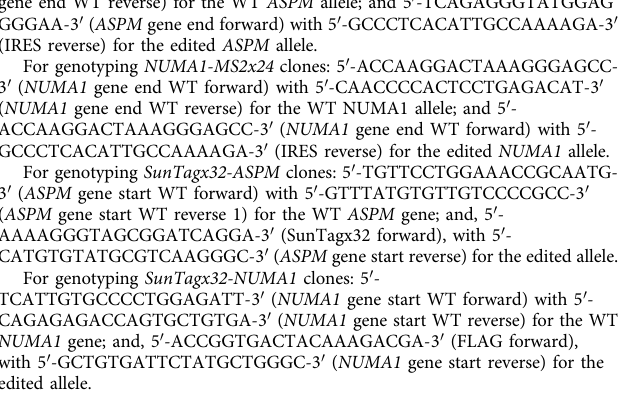
Methods Cell lines, culture conditions, and treatments . HeLa-Kyoto cells and HeLa cells expressing or not Centrin1 – GFP (a gift from Dr. B. Delaval) were grown in Dul-